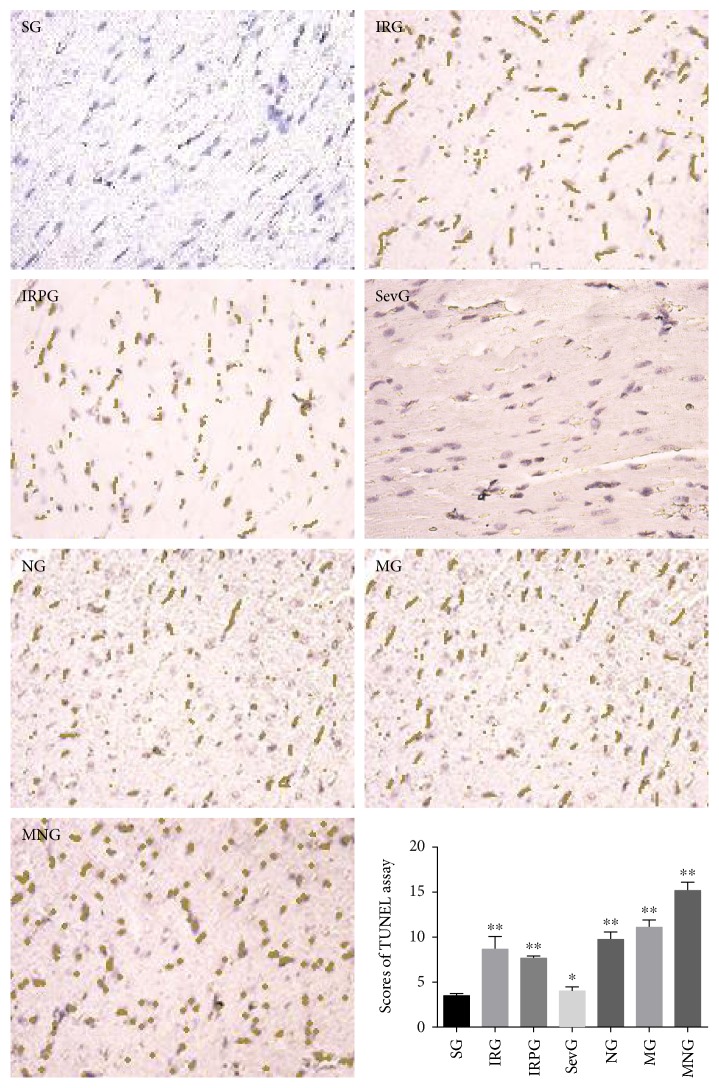
TUNEL analysis for cellular apoptosis in different groups (magnification 400x). The apoptotic rates were presented as mean values ± S.D. ∗P < 0.05 via SG, n = 7. ∗∗P < 0.01 via SG.